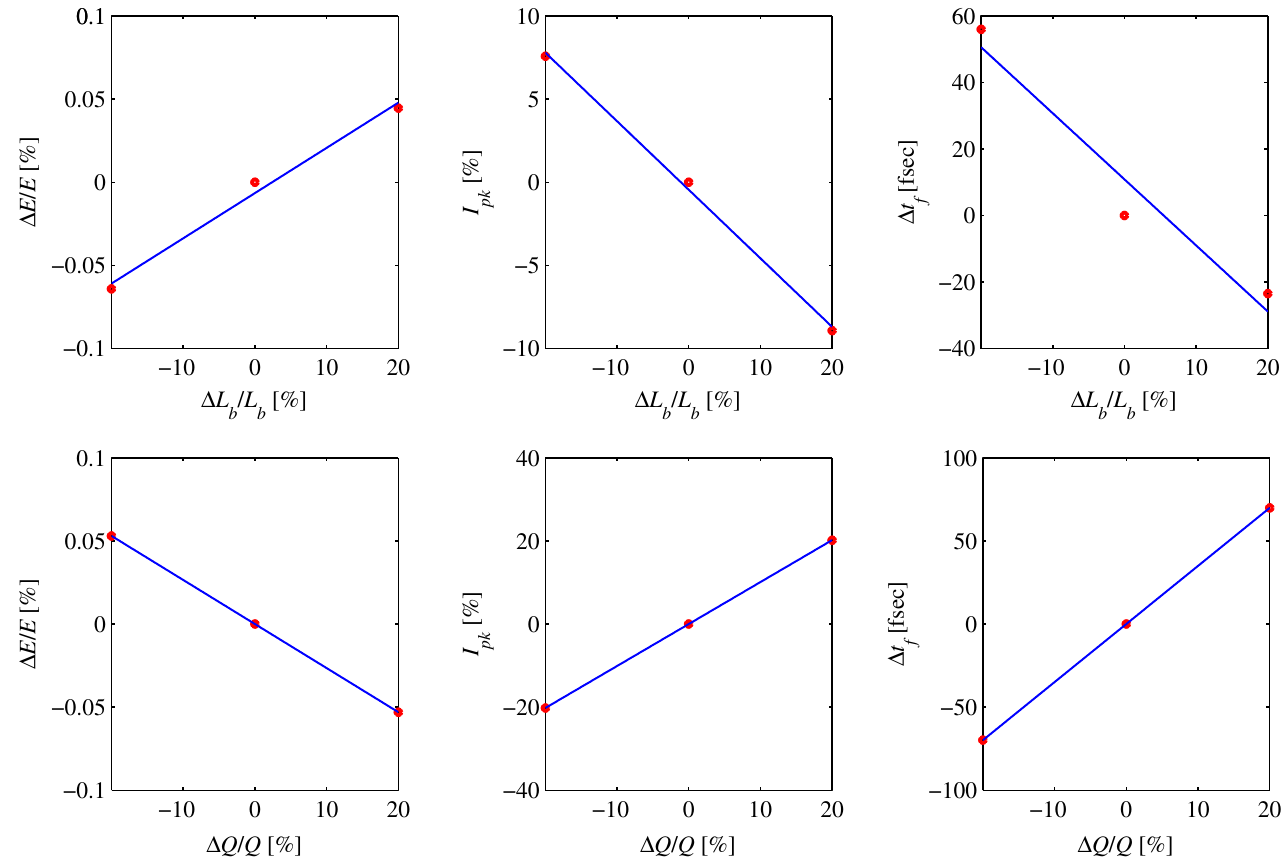
FIG. 7. (Color) Relative mean energy (cid:1) E=E , relative peak current (cid:1) I pk =I pk , and bunch arrival time variations (cid:1) t f as a function of the relative initial bunch length variations (cid:1) L b =L b (upper plots) and relative initial bunch charge variations (cid:1) Q=Q (lower plots).